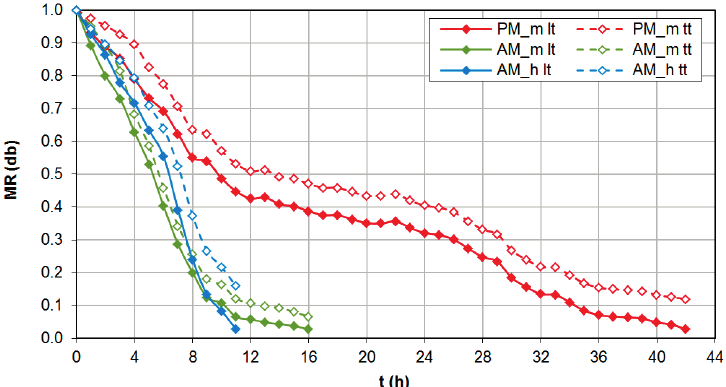
Figure 12. MR (db) for different OMW trays.